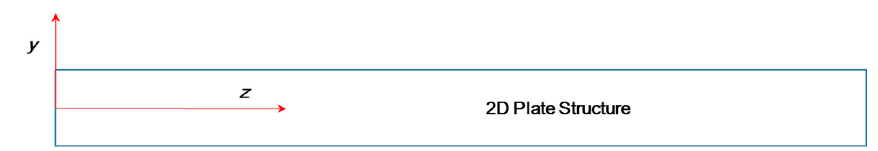
Figure 1. Stress-free 2-D plate structure.